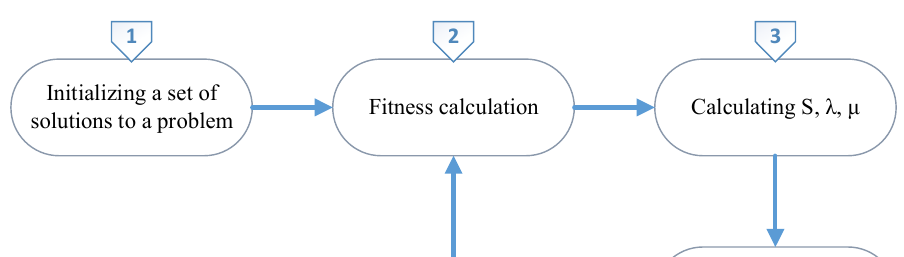
Energies 2020 , 13 , x